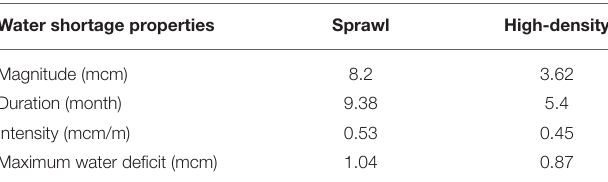
TABLE 2 | Impacts of urban development patterns (sprawl vs. high-density) on water shortage